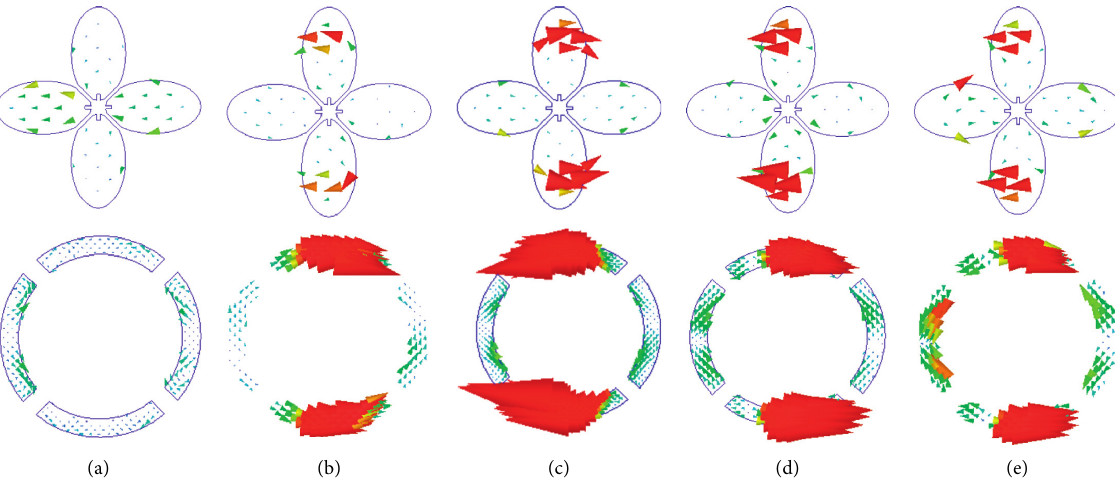
Figure 4: Simulated current distributions on the bowtie patches and SR. (a) 2.6 GHz, (b) 3.5GHz, (c) 4.0 GHz, (d) 4.8GHz, and (e) 5.2 GHz.